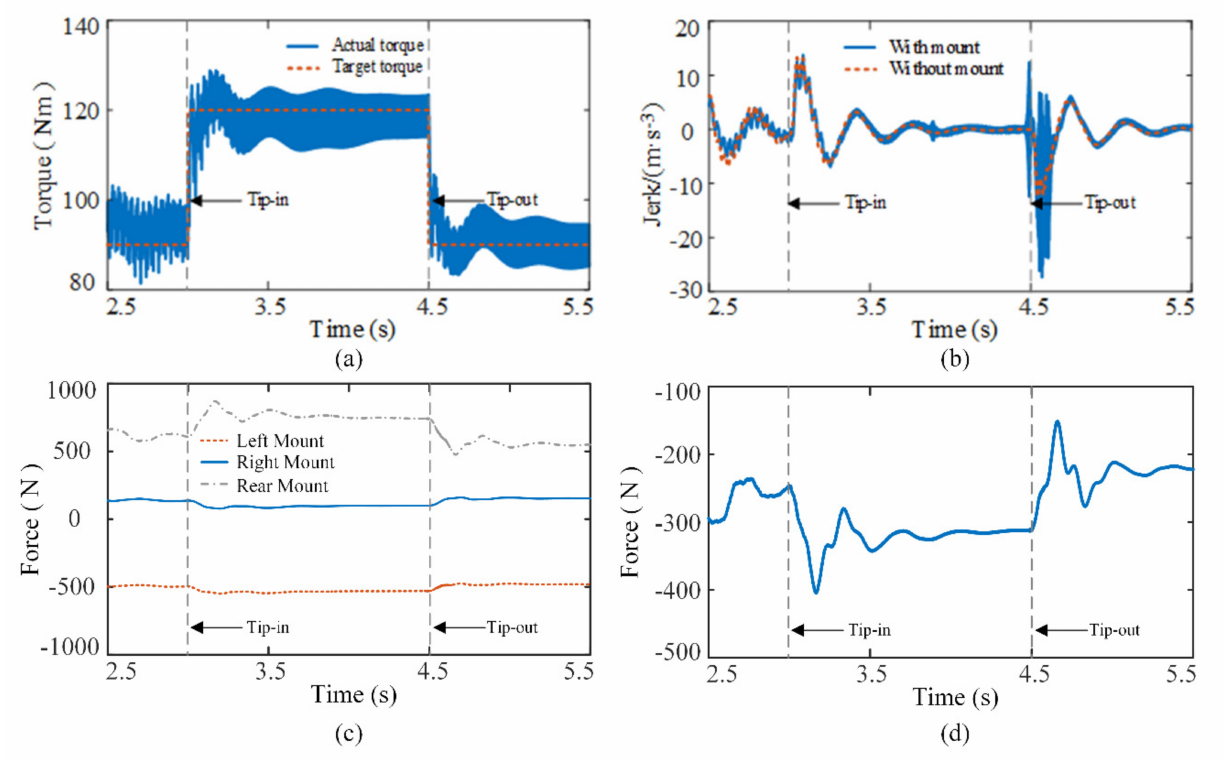
Figure 8. The results of the mount influence on tip-in/tip-out conditions: ( a ) engine torque under tip-in/tip-out conditions; ( b ) vehicle jerk; ( c ) longitudinal force of each mount; ( d ) the longitudinal force of the powertrain on the